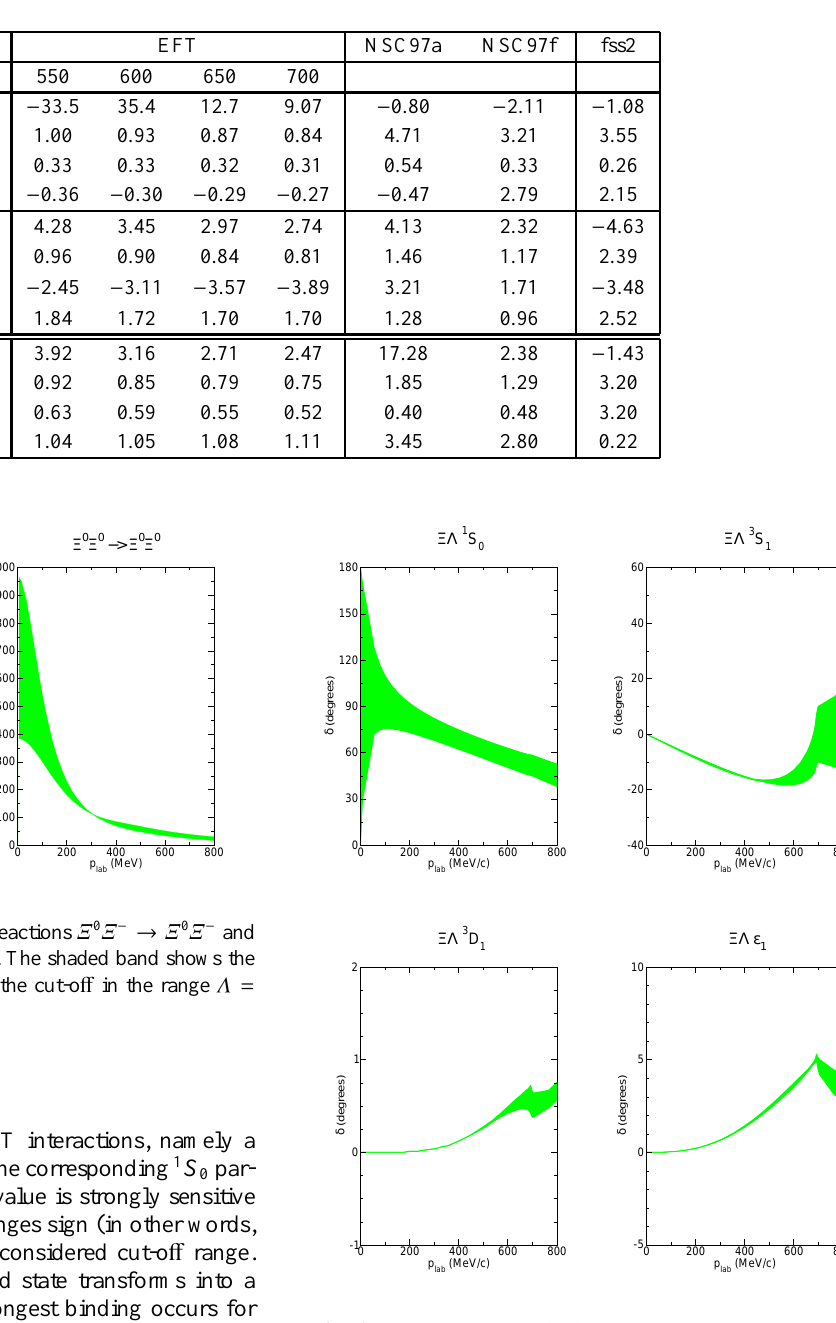
Table 3. Selected Ξ Y and ΞΞ singlet and triplet scattering lengths a and e ff ective ranges r (in fm) for various cut-o ff values Λ . The last columns show results for the Nijmegen potential (NSC97a, NSC97f) [25] and the model by Fujiwara et al. (fss2) [26].